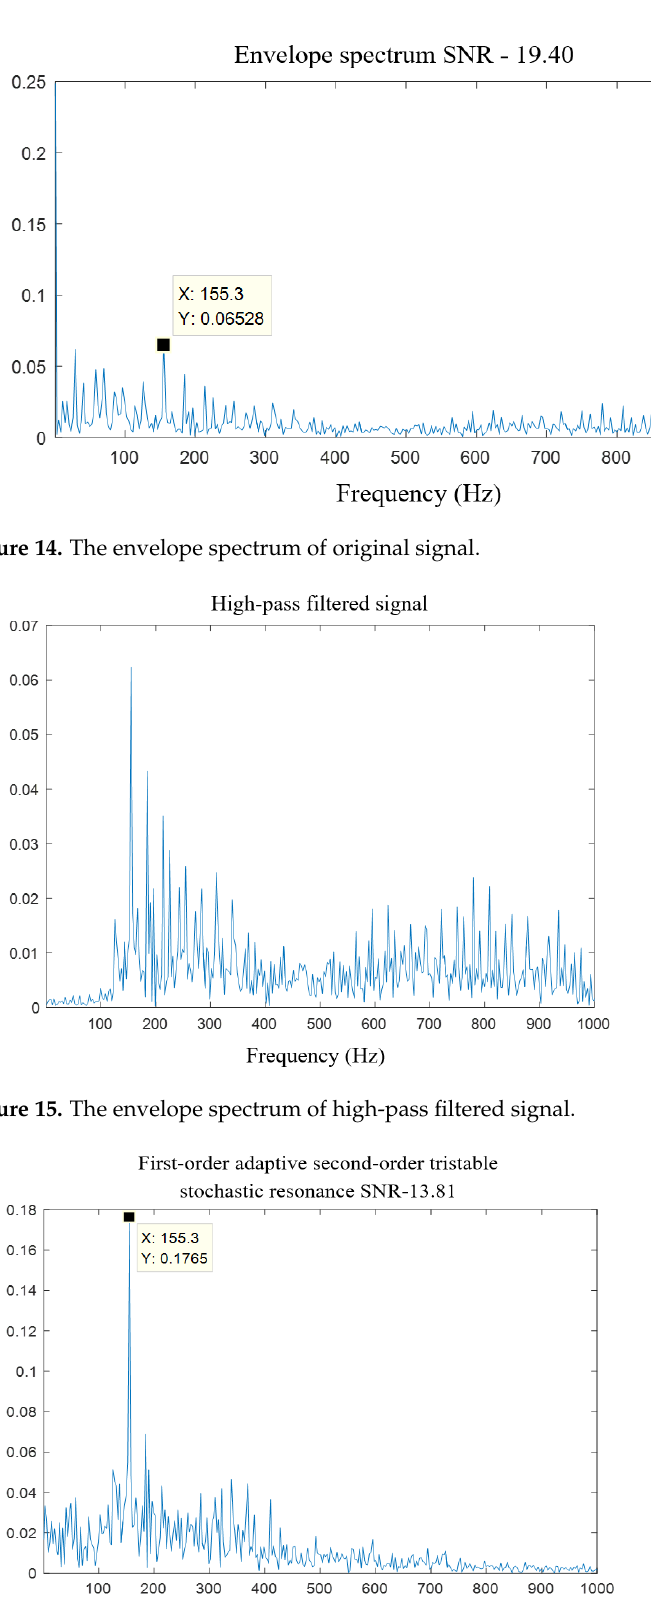
Figure 16. The output spectrum of the first cascade system.